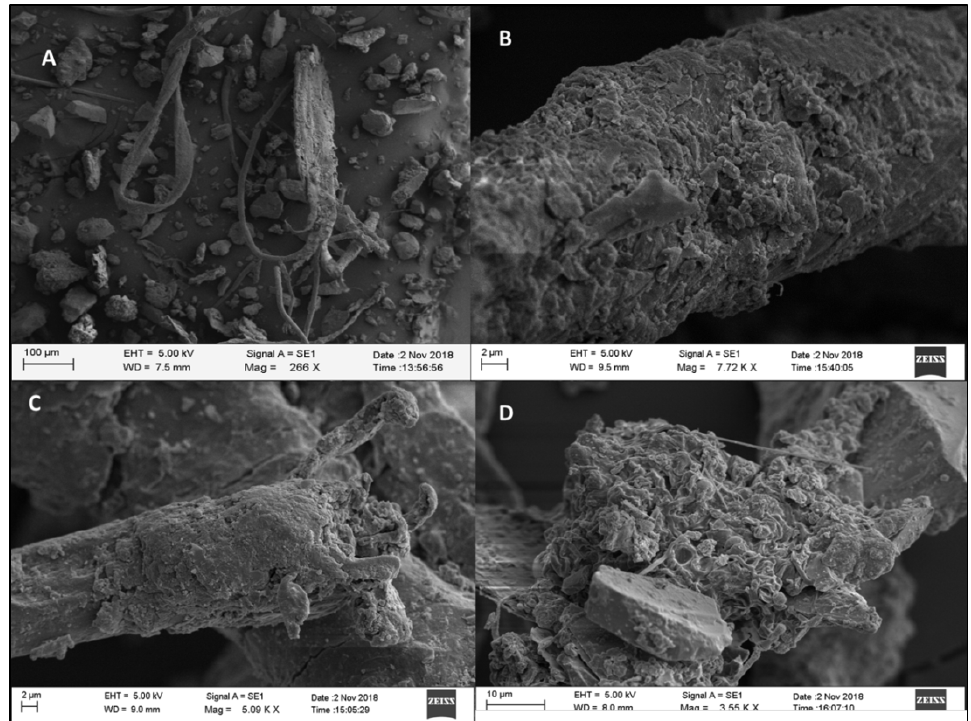
Figure 6: SEM image of (A) porous nature of the surface coating of the fibers in the road dust samples, (B) surface coated cloth fibers which the fibrous nature has been disappeared, (C) fracturing of the surface of a fiber in the sample, (D) the aggregate which contain the materials derived from biological materials; roots and